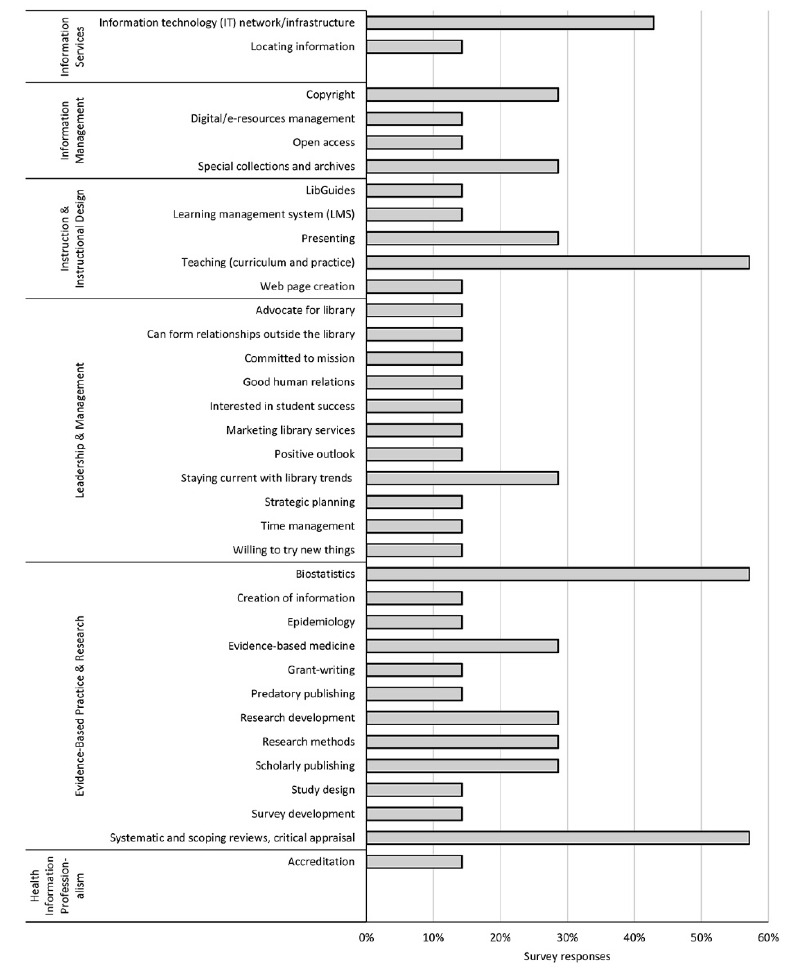
Figure 5 Summary of competencies and skills desired by COM library leaders